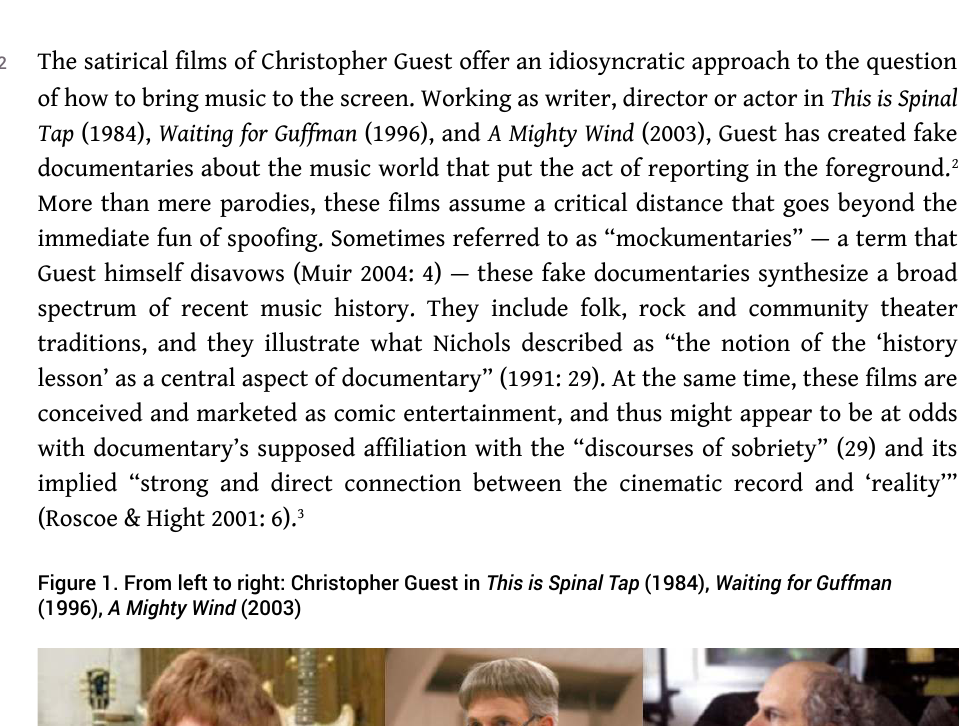
Figure 1. From left to right: Christopher Guest in This is Spinal Tap (1984), Waiting for Guffman (1996), A Mighty Wind (2003)